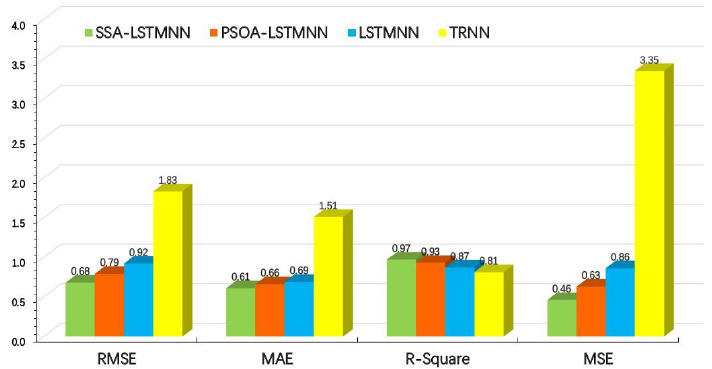
Figure 16. Evaluation results of each model at velocity V 2 = 5000 mm/min.